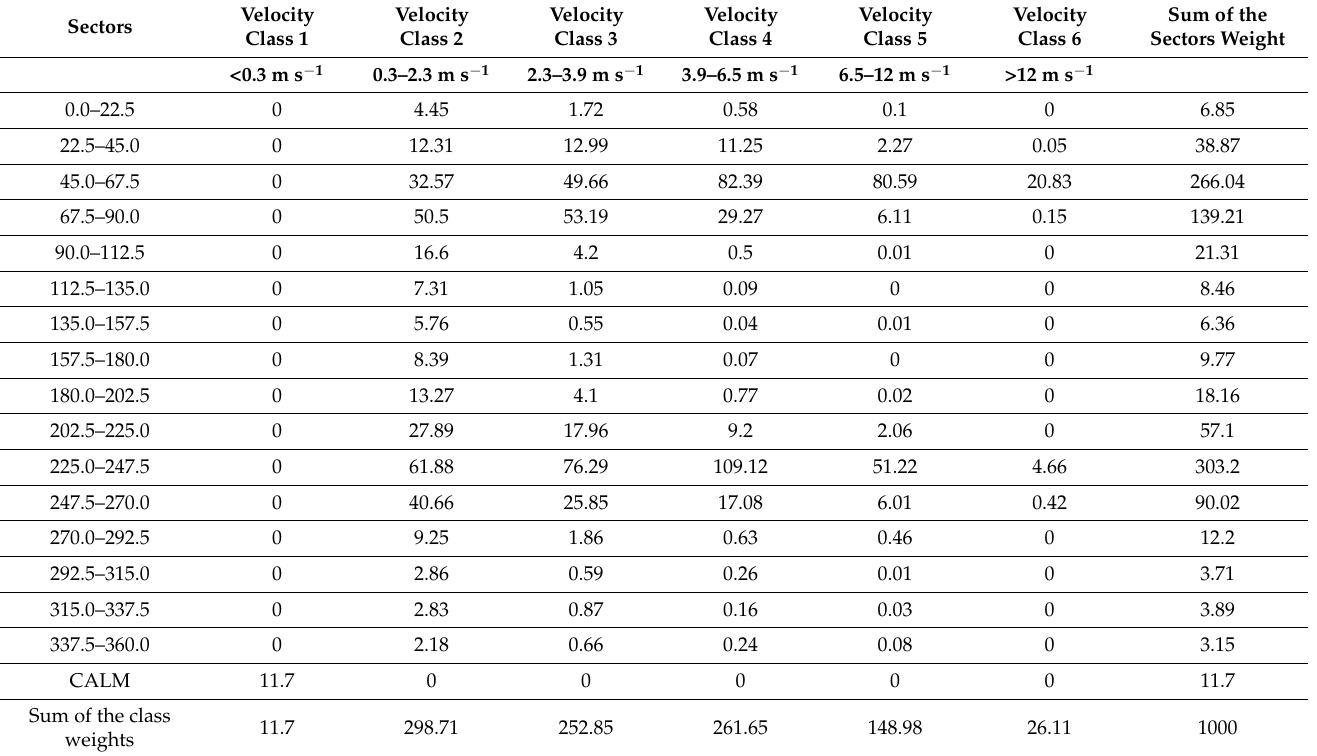
Table 3. Probability distribution of wind speed and